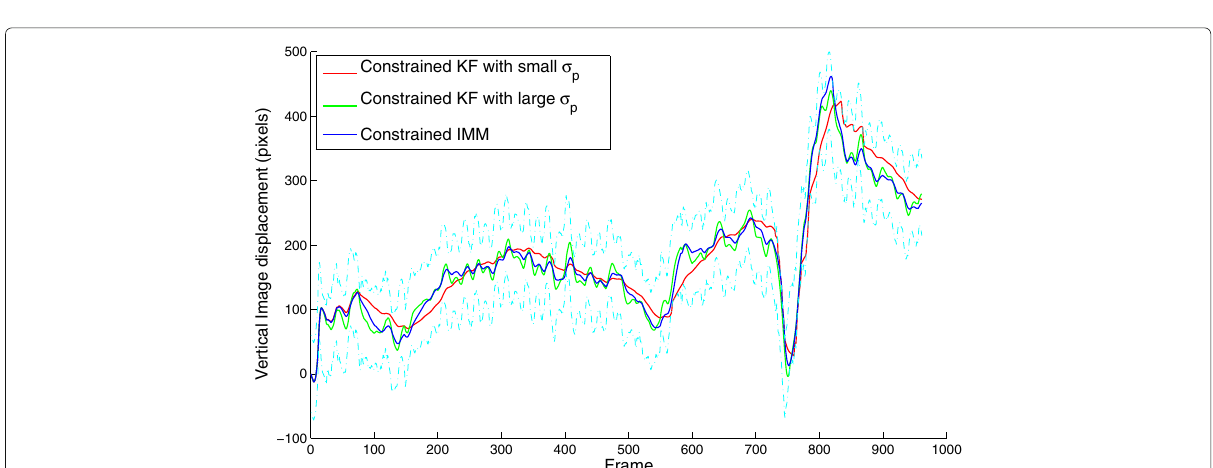
Fig. 8 Video 2 horizontal motion: comparison between single-model constrained Kalman filtering and constrained IMM. Cyancurves are constraint boundaries